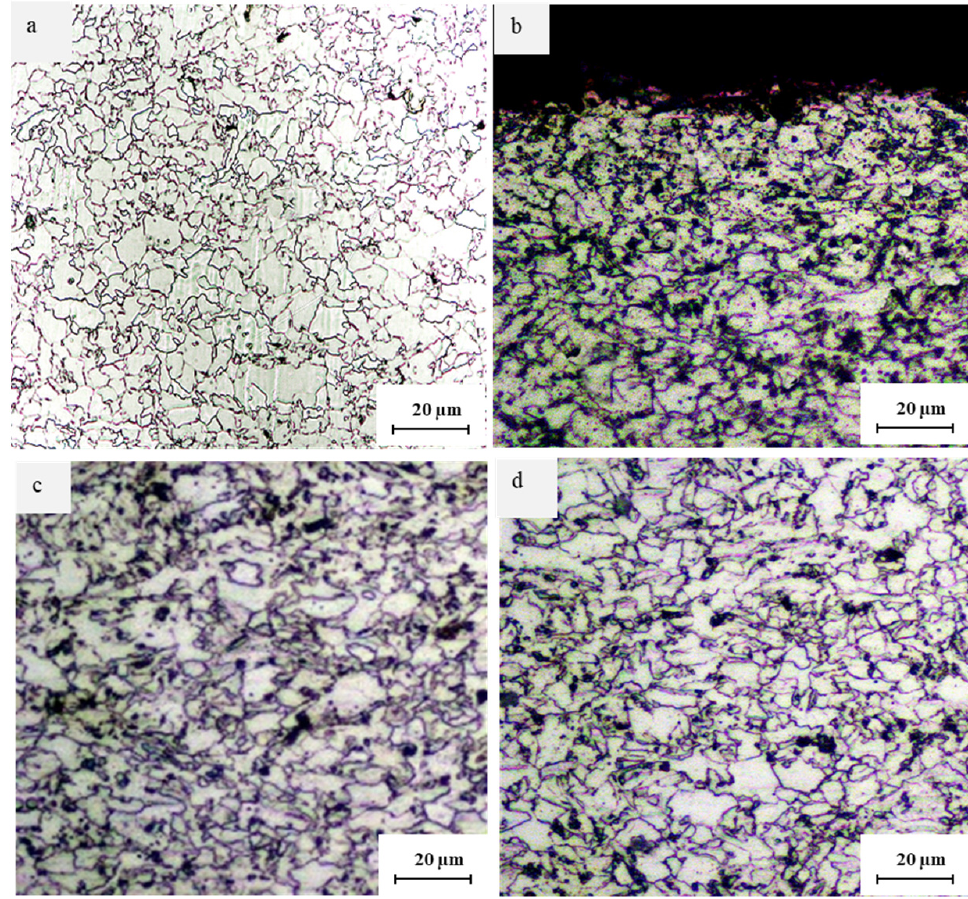
Figure 4. Cross-sectional micrographs of microalloyed steel sample ( a ) in unpeened condition and after laser shock peening at 1064 nm and 9 GW/cm 2 ( b ) in subsurface region, ( c ) below subsurface, region, and ( d ) in midsection region.